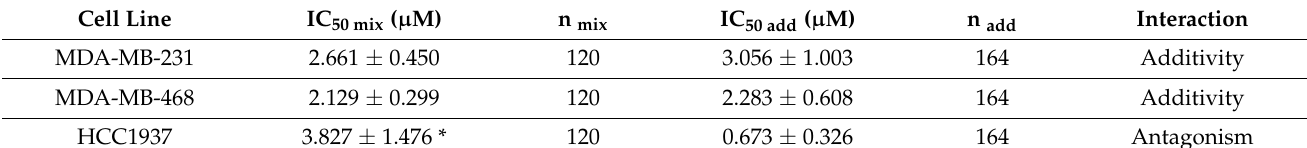
Table 4. Isobolographic analysis for parallel CECs between PAX and AGK2 at the 1:1 ratio in the MDA-MB-231, MDA-MB-468 and HCC1937 cells. The results are IC 50 values (in µM ± SEM) for the two-drug mixtures determined experimentally (IC 50 mix ) and theoretically computed (IC 50 add ) from the equation of additivity that blocked proliferation in 50% of the tested cells; n mix —total number